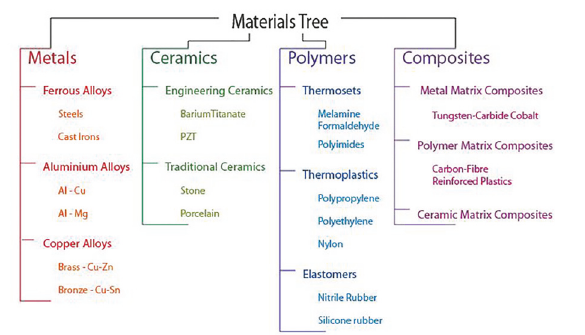
Figure 6: Material classification